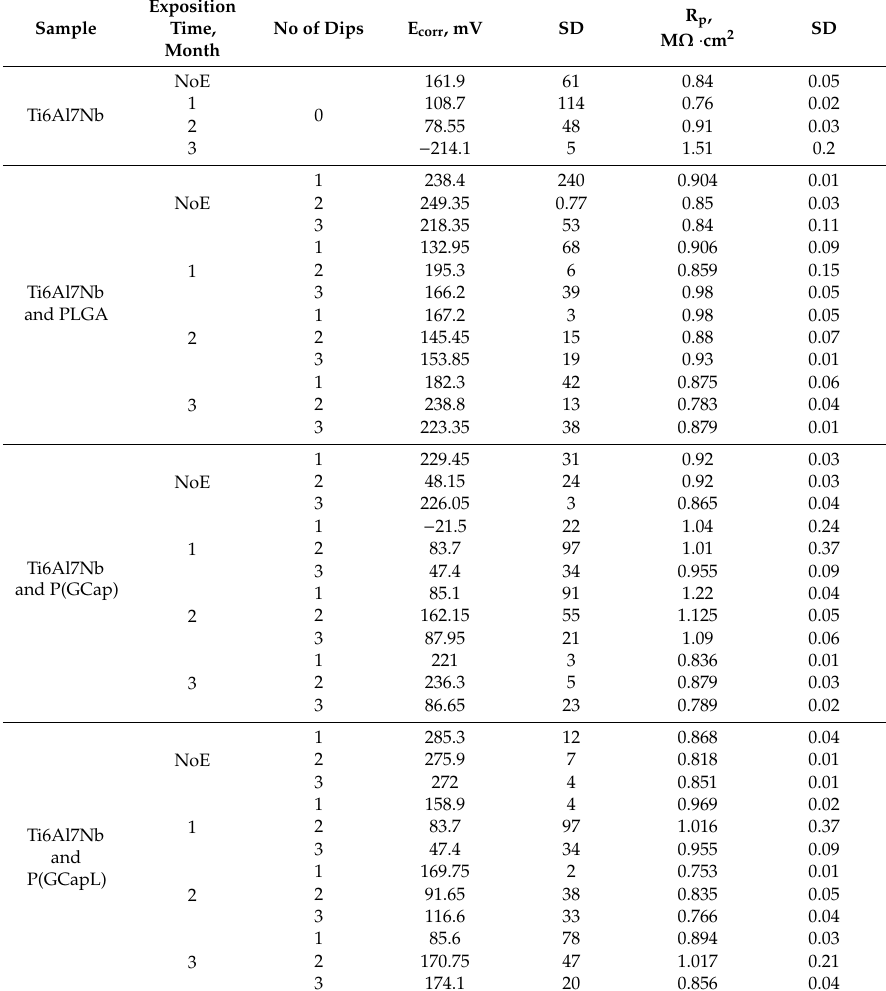
Table 2. Results of potentiodynamic